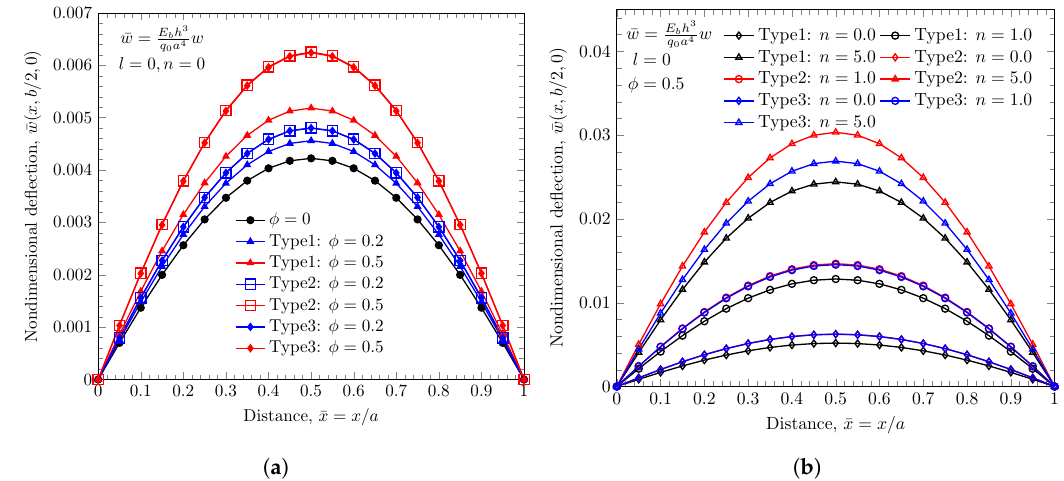
(cid:16) (cid:17) x , b ,0 of homogeneous plate with different porosity 2